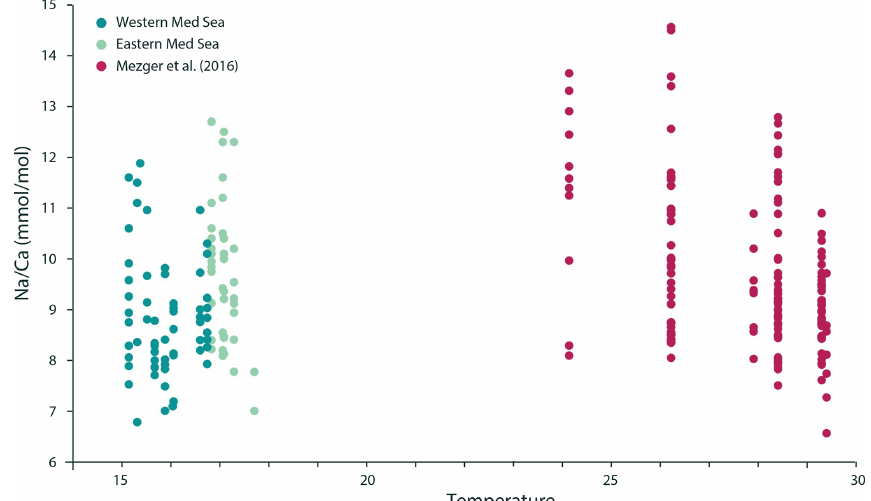
Figure 5. The ratio of Na / Ca in G. ruber albus appears to be independent of seawater temperature. While Mezger et al. (2016) showed a negative relationship between temperature and foraminiferal Na / Ca in specimens collected from the Red Sea, the addition of new data from the Mediterranean Sea clearly shows that the previously hypothesized negative impact of temperature on Na / Ca is likely an artefact of the negative relationship of temperature and salinity in the Red Sea and that temperature has no significant impact on Na / Ca.